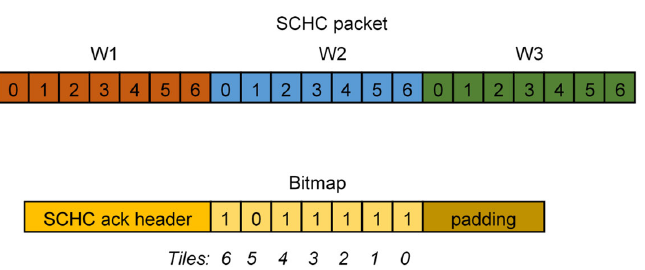
Figure 5. Example of an SCHC packet with three windows W of seven tiles each and the bitmap in the SCHC ACK describing if there are missing tiles in the acknowledged window (note that tile 5 is missing in this case.).